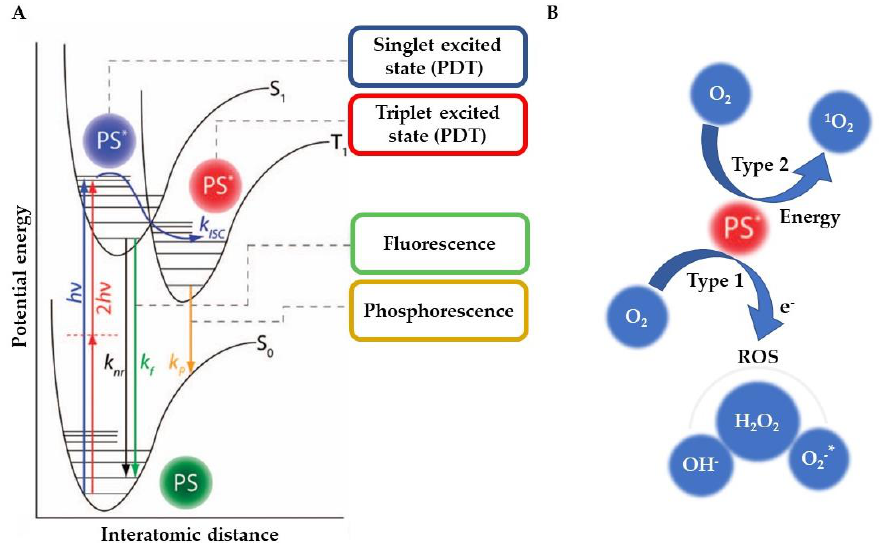
Figure 1. Perrin–Jablonski energy diagram for a photosensitizer (PS). ( A ) The absorption of a photon (h ν ) leads to electronic excitation to singlet (S 1 ) or triplet (T 1 ) states. In the singlet state, the photosensitizer can react with neighboring molecules, or transition to the triplet excited state, T 1 , by intersystem crossing (ISC), or relax, S 0 , with energy dissipation (nr). ( B ) Type 1 and 2 reactions. The triplet state is the longest-lived state; hence it mediates the biological and photochemical reactions that lead to the production of radical species through the transfer of electrons to oxygen or other electron-accepting cell substrates, type 1 reaction, or the transfer of energy for oxygen molecules with formation of singlet oxygen ( 1 O 2 ), type 2 reaction. The 1 O 2 -mediated photodynamic mechanism is the most important for PDT-induced cytotoxicity.